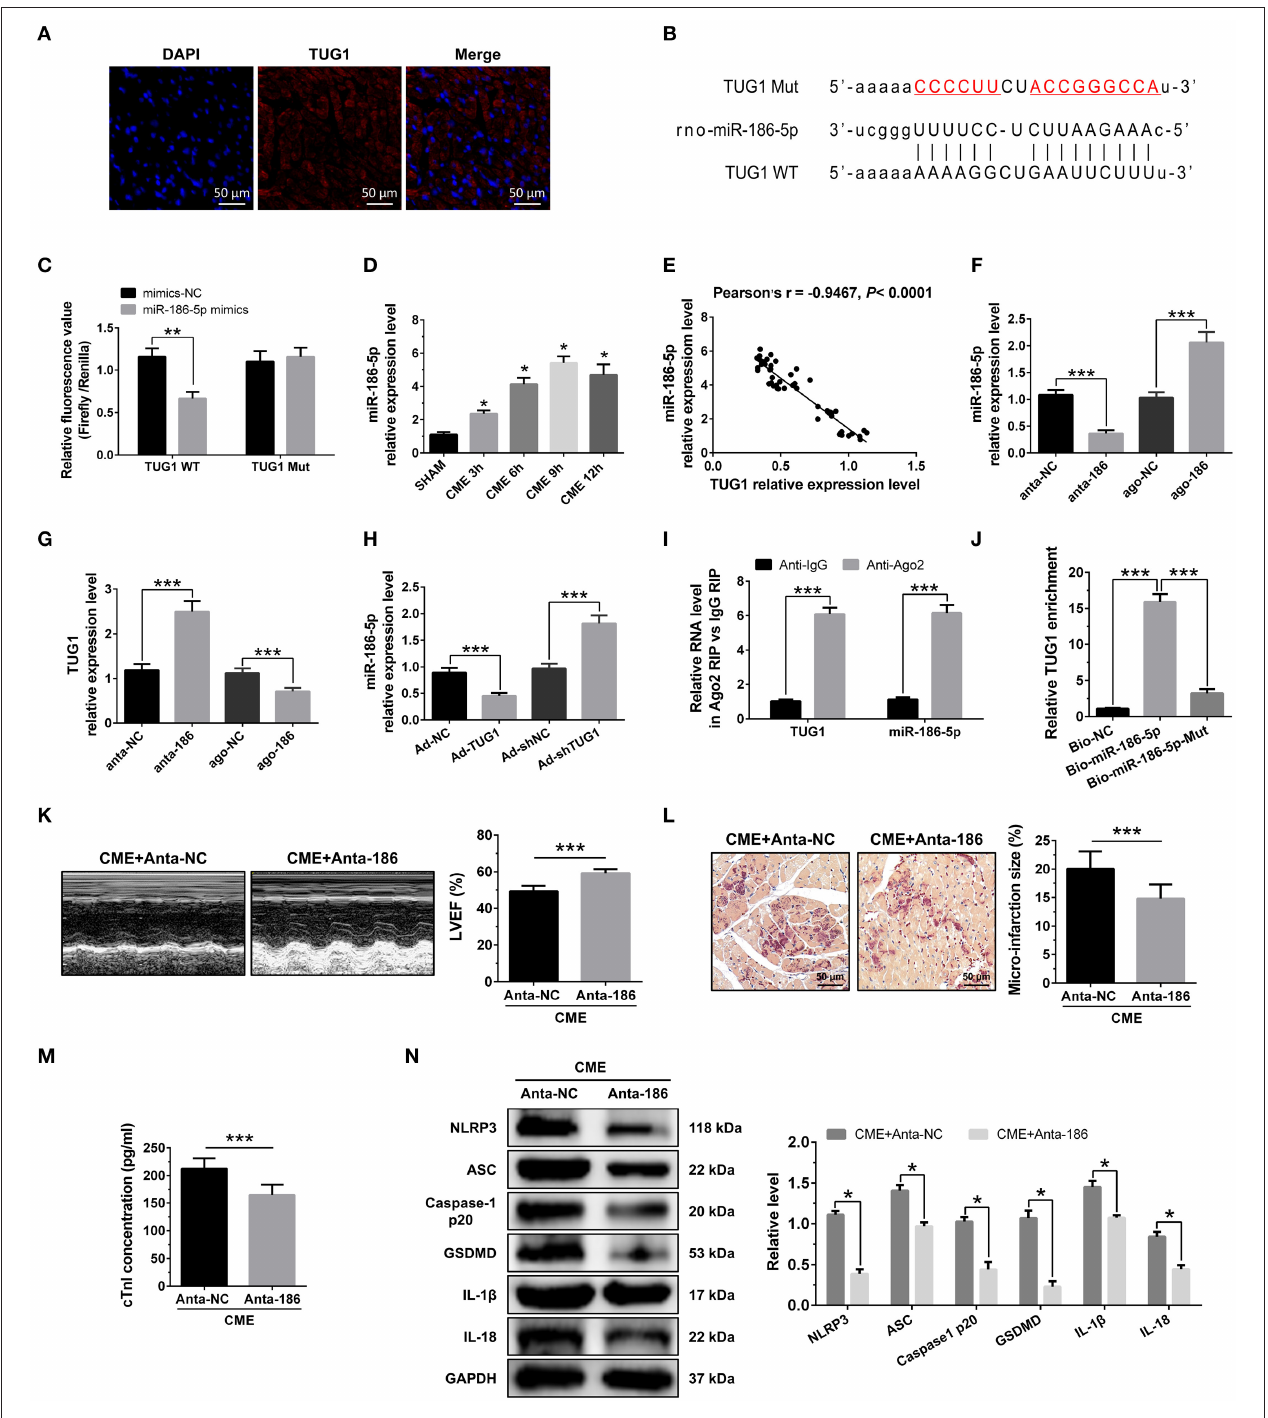
FIGURE 4 | MiR-186-5p is a direct target of TUG1 and regulates CME-induced myocardial injury. (A) Representative images of fluorescence in situ hybridization (FISH) for TUG1 in CME heart tissue (magnification, × 400; bar = 50 µ m). (B) The predicted binding region between miR-186-5p and TUG1 was predicted by using bioinformatics analysis. (C) Relative luciferase activity in WT-TUG1 and MUT-TUG1. (D) Myocardial miR-186-5p levels were assessed via qRT-PCR ( n = 10), * P < 0.05 vs. SHAM group. (E) MiR-186-5p level was negatively correlated with TUG1 level in heart tissue. (F) MiR-186-5p was silenced or overexpressed with antagomiR or agomiR; qRT-PCR was used to detect the transfection efficiency ( n = 3). (G) The expression levels of TUG1 were tested in miR-186-5p-downregulated or miR-186-5p-overexpressed rats with qRT-PCR ( n = 10). (H) The expression levels of miR-186-5p were tested in TUG1-downregulated or TUG1-overexpressed